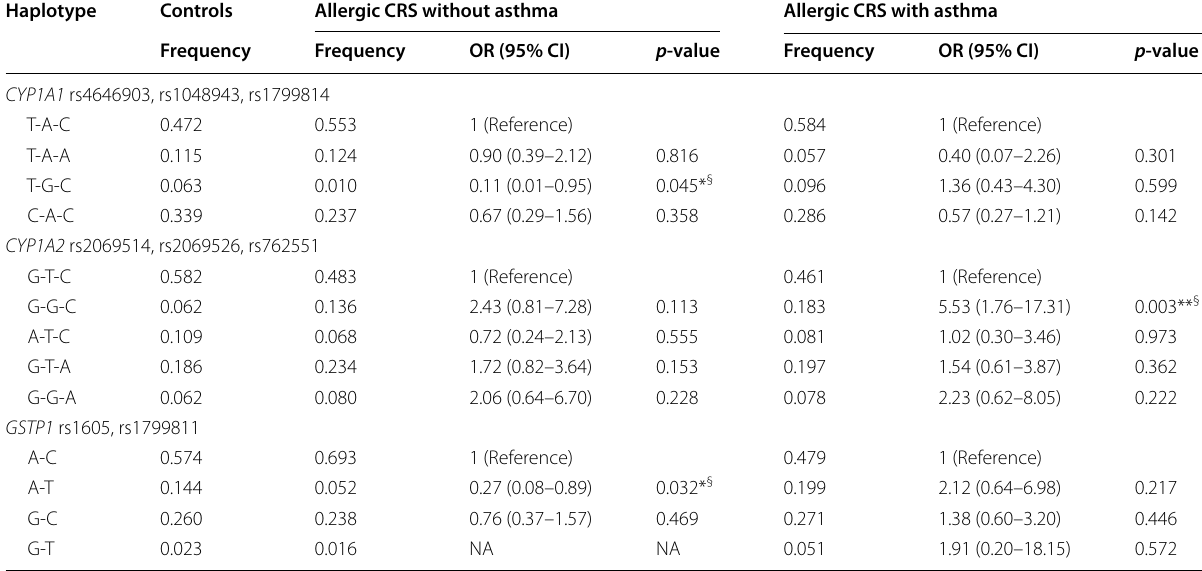
Haplotypes with a frequency OR Odds ratio, CI Confidence interval Significance of * p -value